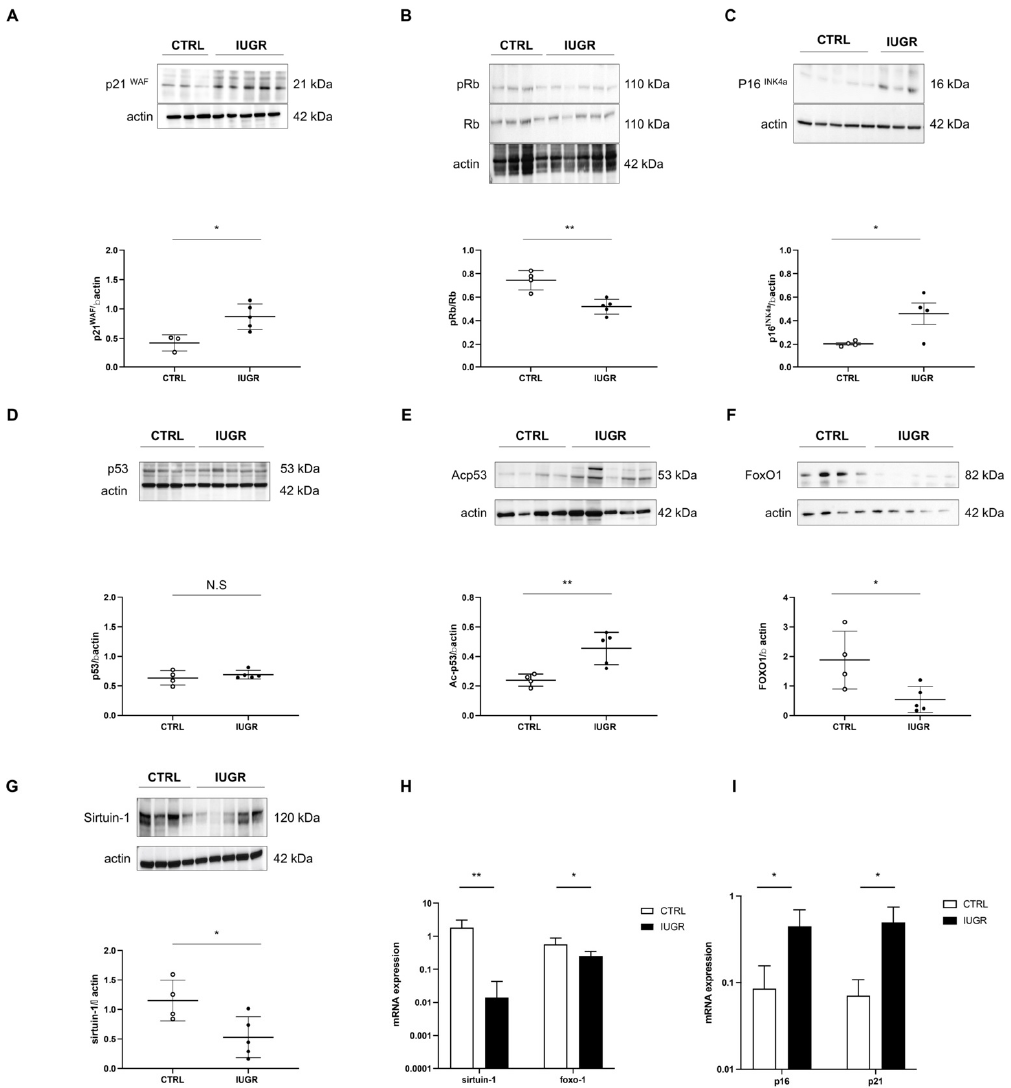
Figure 12. Molecular pathways related to cellular senescence in CTRL and IUGR male livers at 6 months of age. The protein expression of p21 WAF ( A ), pRb/Rb ( B ), p16 INK4a ( C ), p53 ( D ), Acp53 ( E ), FoxO1 ( F ) and sirtuin-1 ( G ) were measured using Western blotting in the CTRL and IUGR groups. * p < 0.05; ** p < 0.01; N.S: not significant. n = 3–5 animals/group. mRNA expressions of foxo-1 and sirtuin-1 ( H ), p16 and p21 ( I ) normalized to β -actin were measured in the CTRL and IUGR groups using RT–qPCR. * p < 0.05; ** p < 0.01; n = 3–5 animals/group.